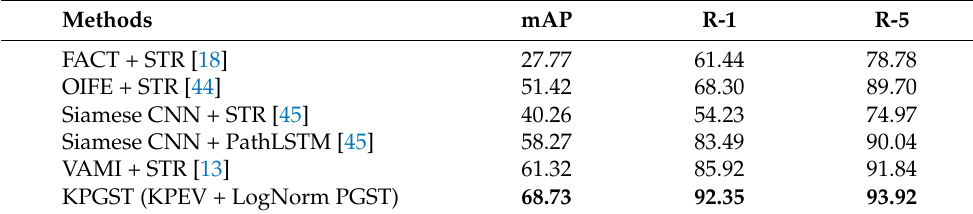
Table 9. Comparisons (%) with our KPGST and state-of-the-art Re-ID methods on the VeRi-776 dataset. The best results are shown in